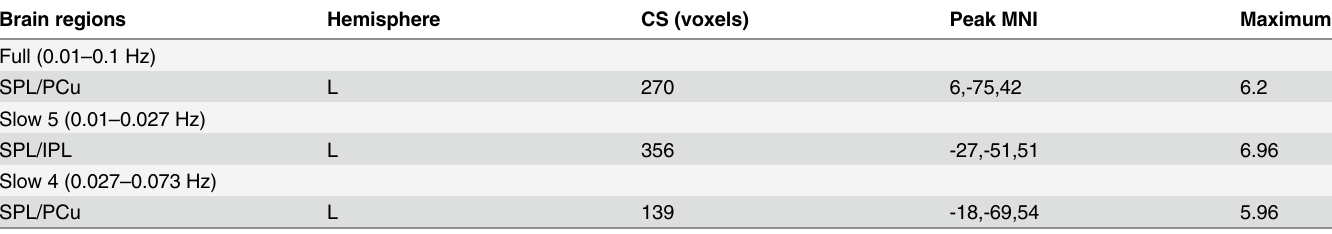
Table 3. Regions showing increased ReHo in stroke patients versus normal controls.